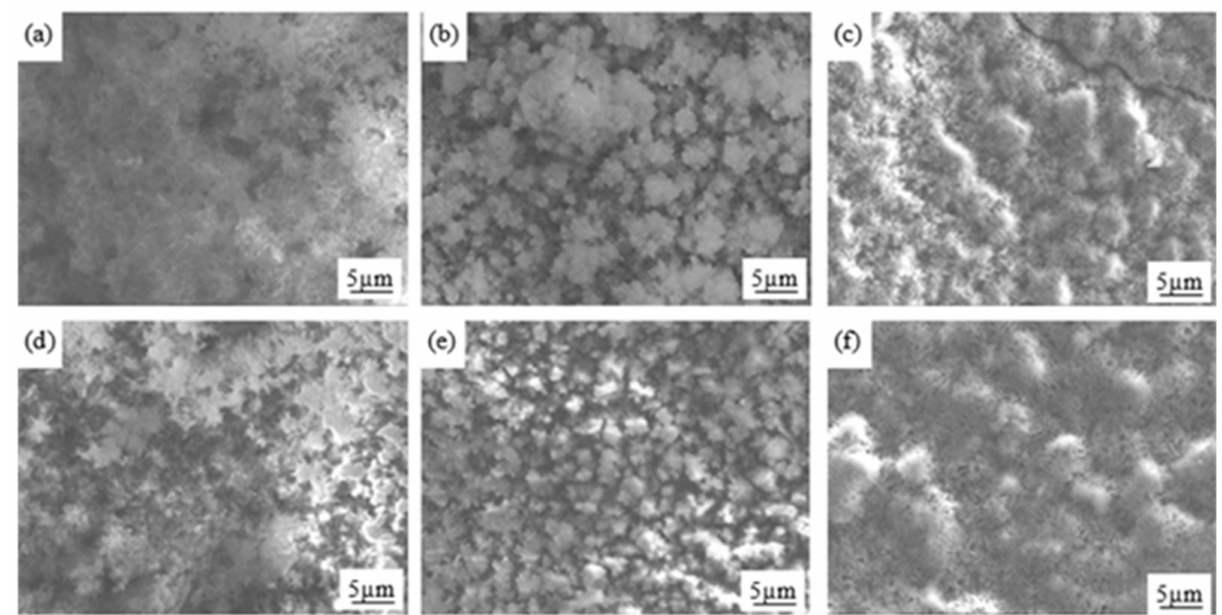
Figure 3. Micromorphology of rust layer of experimental steel after corrosion for different time: ( a – c ) 60Si2Mn-A after corrosion for 24 h, 72 h, and 360 h; ( d – f ) corrosion resistant 60Si2Mn-B after corrosion for 24 h, 72 h, and 360 h.